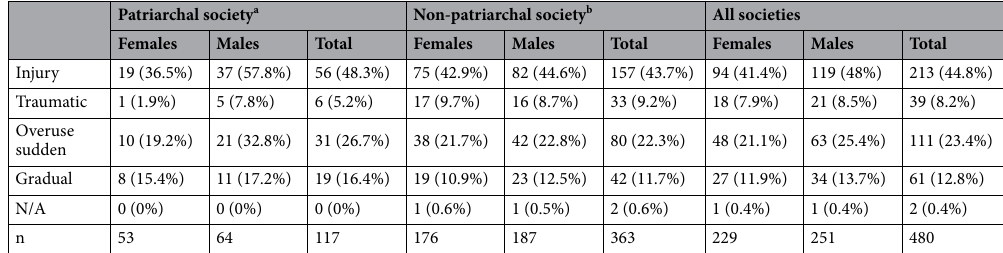
Table 2. Prevalence of pre-competitions injury (≥ 3 week stime-loss) in numbers (percent) among participating adolescent Athletics athletes (n = 480) displayed by injury type, sex, and category of society. a Asia, Africa, b Europe, the Americas,